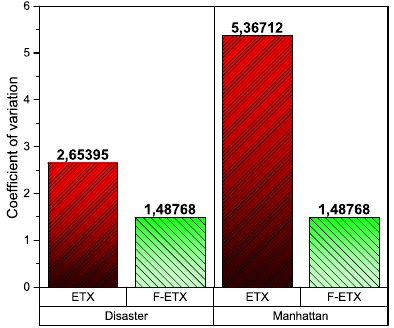
Figure 7. ETX vs F-ETX : Stability